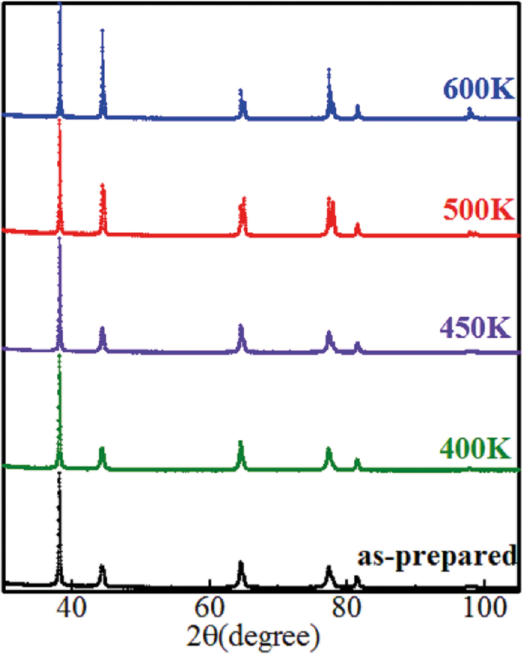
Figure 2. X-ray diffraction patterns of n -Ag after annealing at elevated temperatures for 30 min.